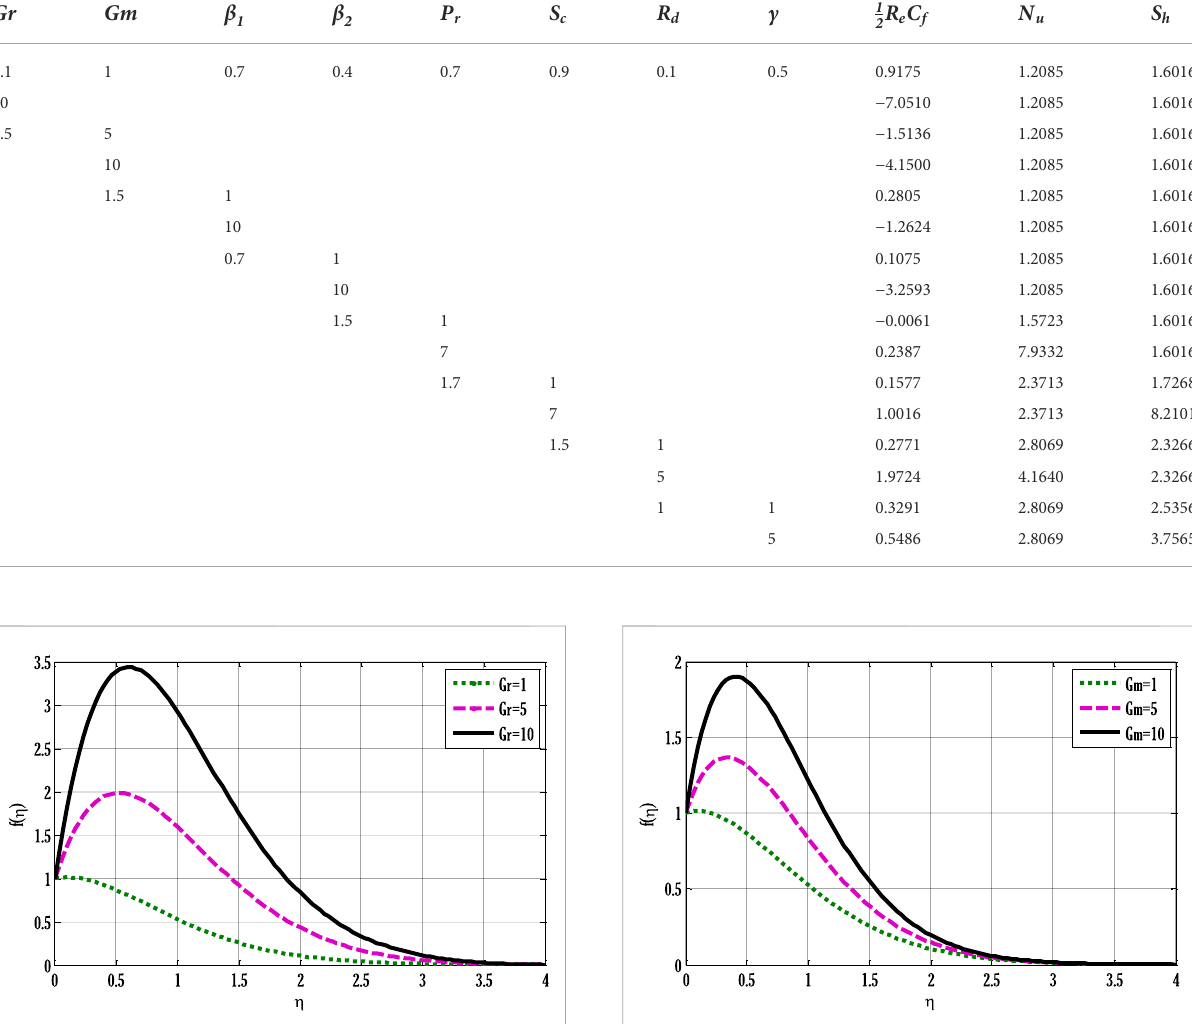
FIGURE 3 Effect of modi fi ed (solutal) Grashof number on